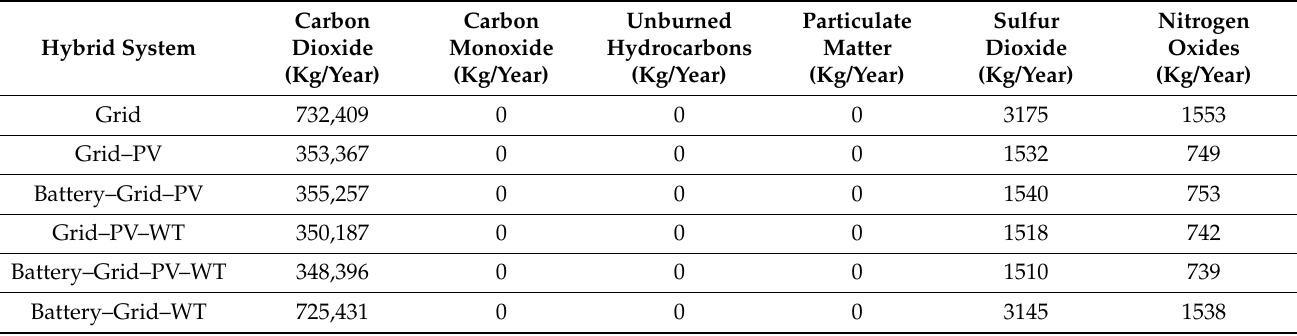
Table 6. Comparison of the GHG emissions produced by each hybrid